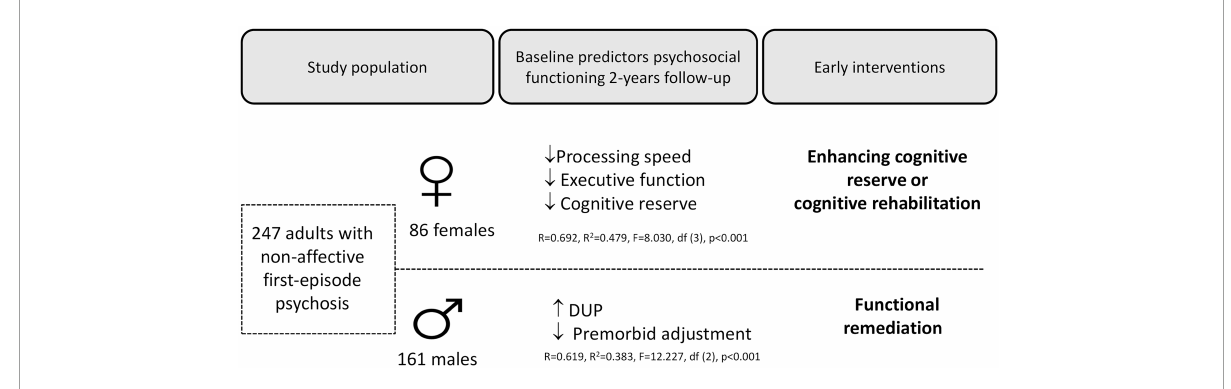
FIGURE1 Overview of the study population, the main results, and the recommended intervention.